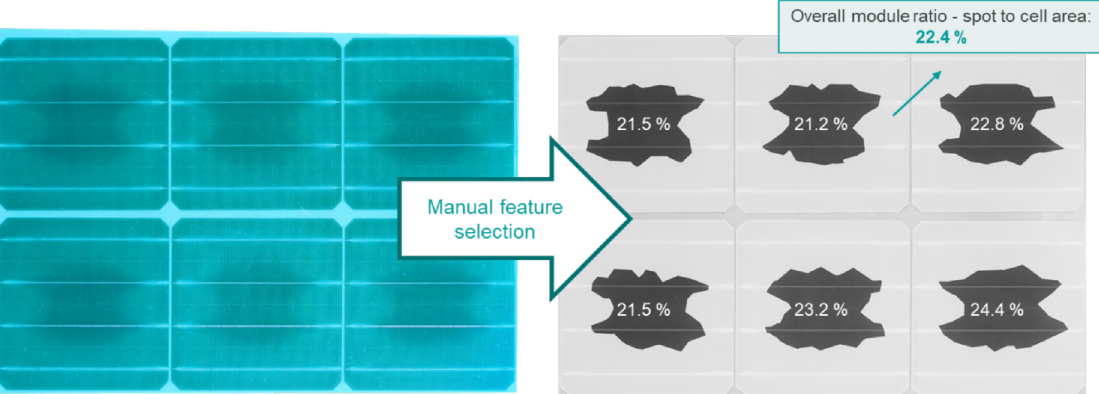
Fig. 2. Manual extraction of UVF patterns on cell/module level.